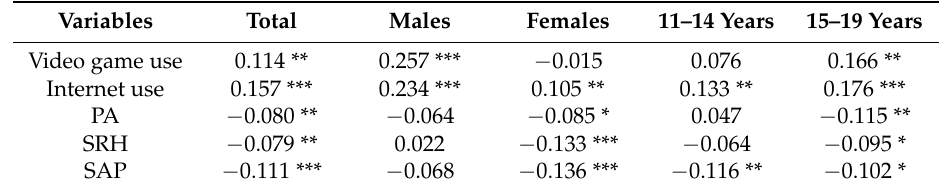
Table 3. Correlation of television viewing with sedentary behaviors, PA, SRH, PBI and SAP.